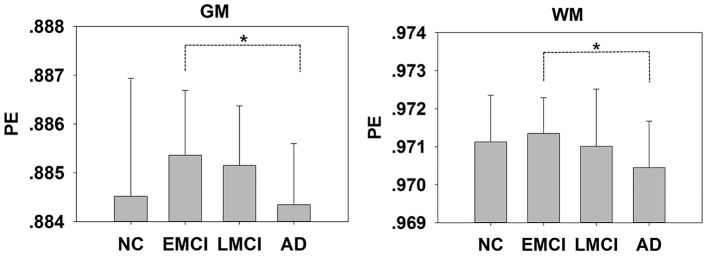
Mean PE values of the gray matter (GM) and white matter (WM) in the NC, EMCI, LMCI, and AD subjects. Significant differences between pairs of groups after Bonferroni correction (P < 0.05) are indicated. *P < 0.05. The error bars indicate the SDs.